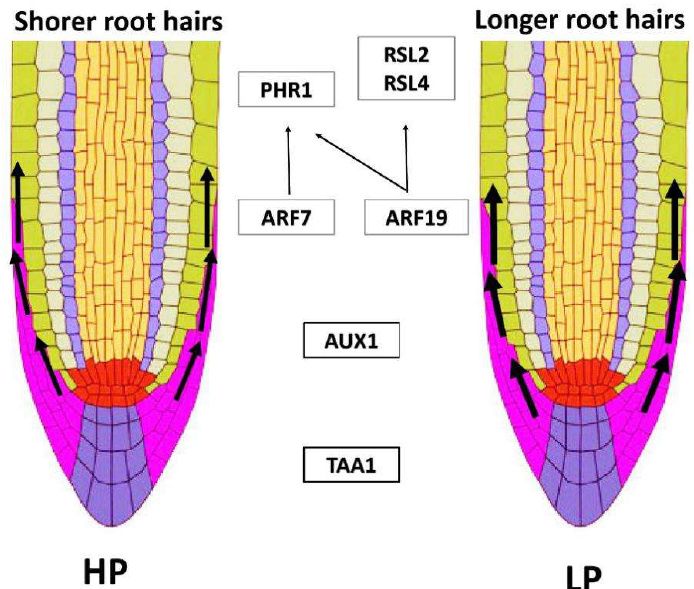
Figure 2. Schematic illustration of root-hair elongation under low phosphate conditions [13,14]. LP elevated the auxin levels of elongation and root-hairs zone by increasing auxin biosynthesis from higher expression of AtTAA1 in root tip and enhanced AUX1-mediated auxin transport through lateral root cap and epidermal cells. The increased auxin levels lead to the induced expression of AtRSL2 / 4 and AtPHR1 regulated by AtARF7 / 19 in elongation zone and di ff erentiation zone, finally promoting root-hair elongation. Black arrows indicate the auxin transport rate and direction (left, less auxin transport; right, more auxin transport). HP/LP—high/low phosphate conditions.